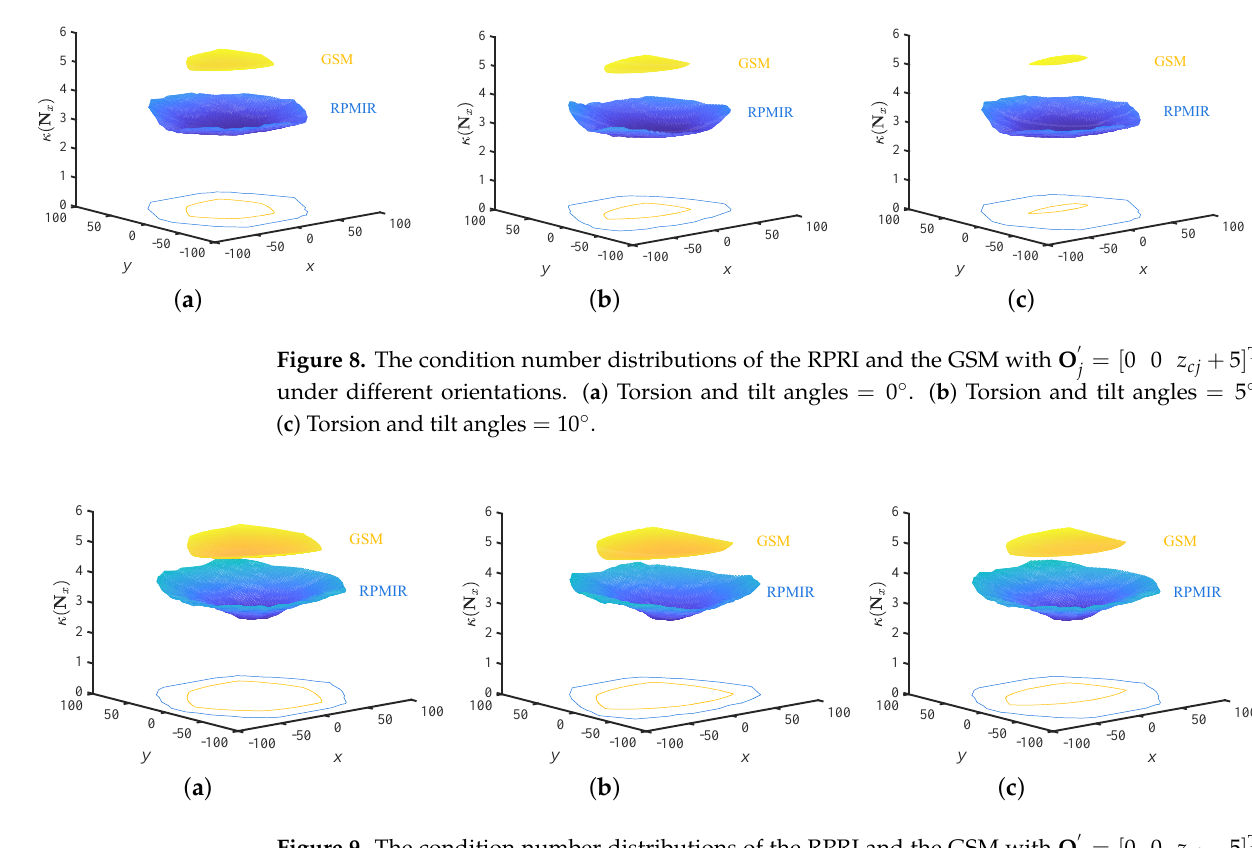
Figure 9. The condition number distributions of the RPRI and the GSM with O (cid:48) under different orientations. ( a ) Torsion and tilt angles = 0 ◦ . ( b ) Torsion and tilt angles = 5 ◦ . ( c ) Torsion and tilt angles = 10 ◦